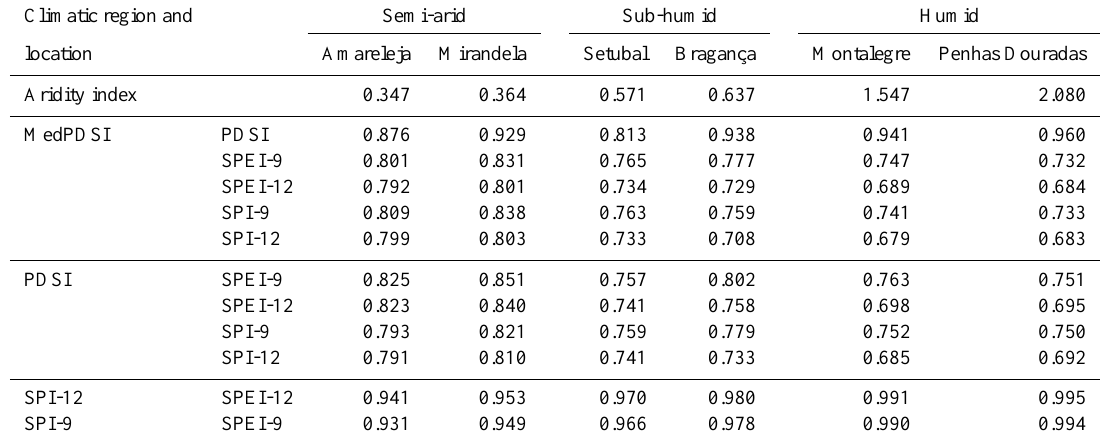
Table 2. Pearson correlation coefficient between monthly values of drought indices in selected stations representing different climates (1941–2006). Climatic region and Semi-arid Humid location Amareleja